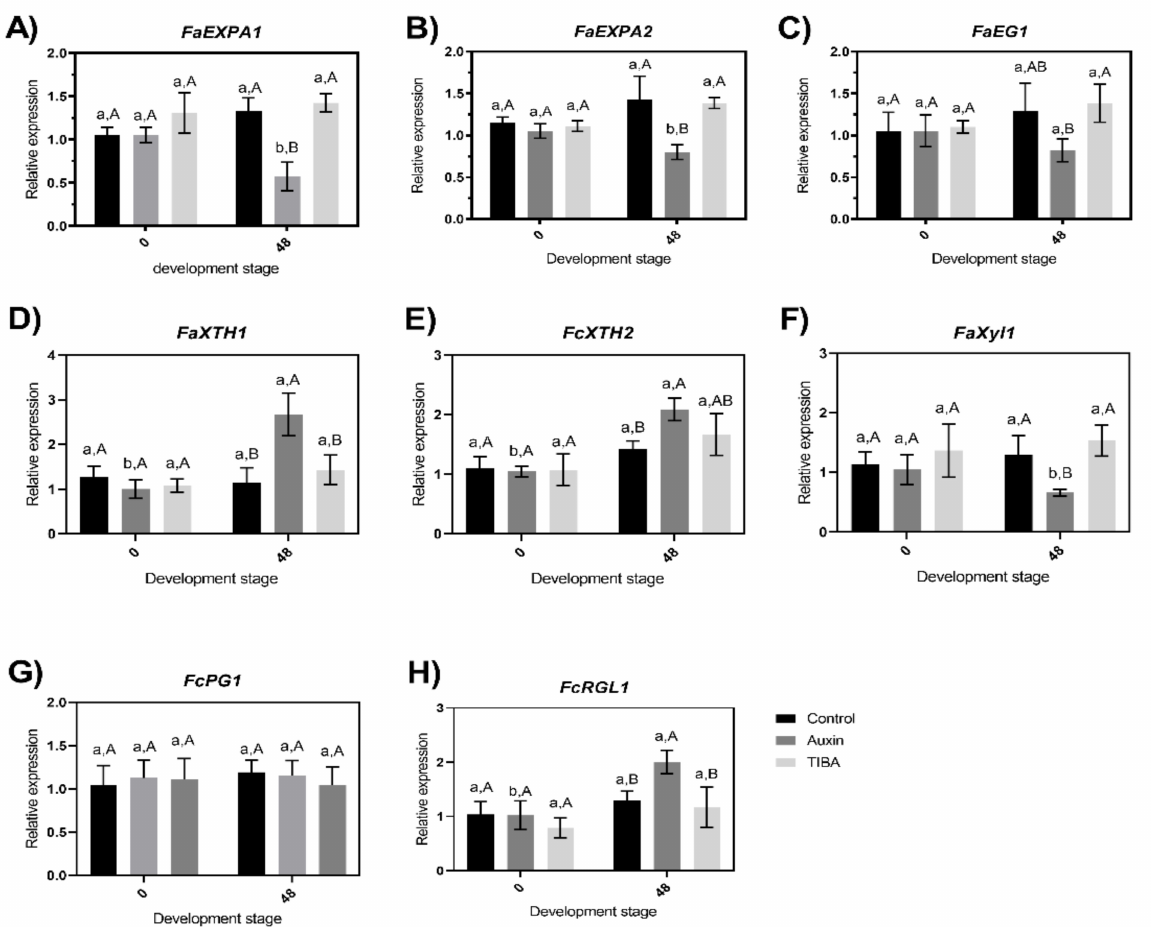
Figure 6. mRNA levels measured by RT-qPCR after auxin, TIBA, and control treatment of eight genes encoded by enzymes and proteins related with the cell wall remodeling. The expression data correspond to the mean of the three replicates normalized against FaGADPH1 abundance. Different letters indicate significant differences between cultivars and stages ( p < 0.05). The F. x ananassa genes correspond to: two expansins A, FaEXPA1 ( A ) and FaEXPA2 ( B ), one endoglucanase ( FaEG1 ) ( C ), two xyloglucan endotransglycosylase/hydrolases : FaXTH1 ( D ) and FaXTH2 ( E ), one β -xylosidase ( FaXyl1 ) ( F ), polygalacturonase ( FaPG1 ) ( G ) and rhamnogalacturonate lyase ( FaRGL1 ) ( H